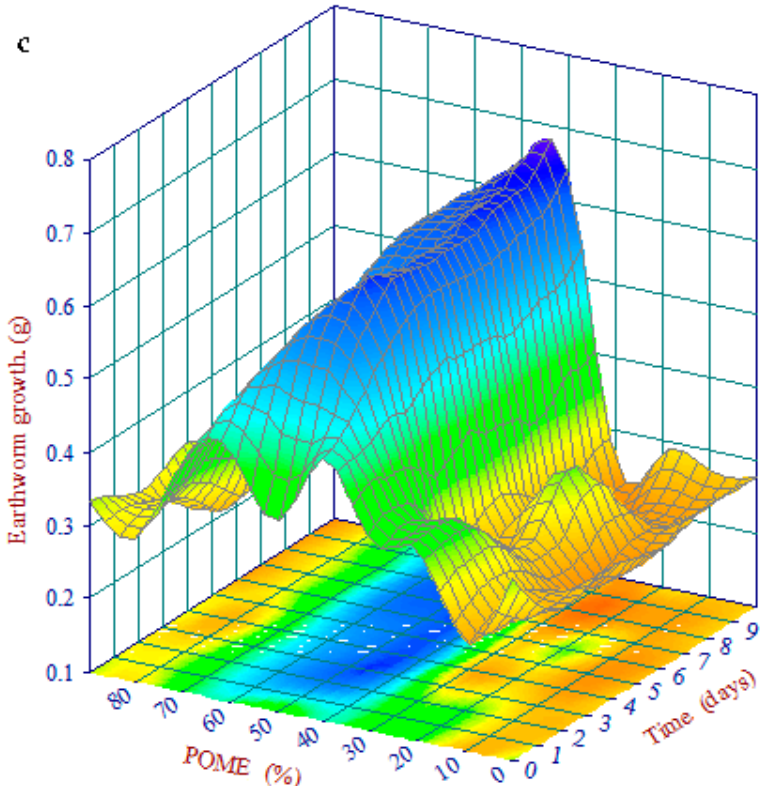
Figure 2. Three-dimensional response surface plot of ( a ) pH, ( b ) C:N ratio and ( c ) EW.